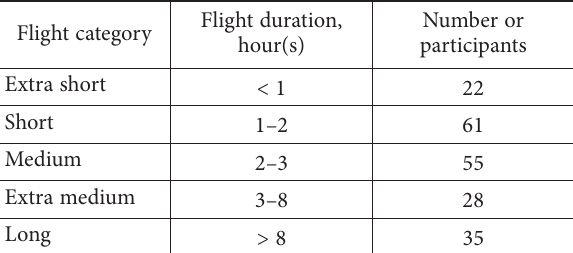
Table 3. Flight category based on flight duration and the corresponding number of participants